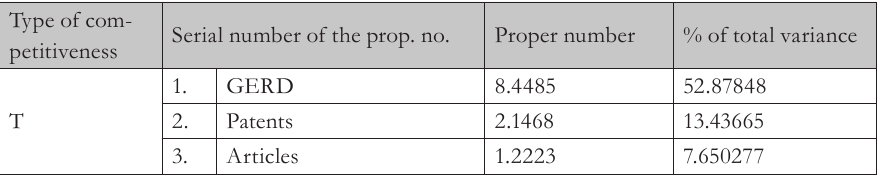
Tab. 1 – Values of the correlation matrix for the indictor of quality-based